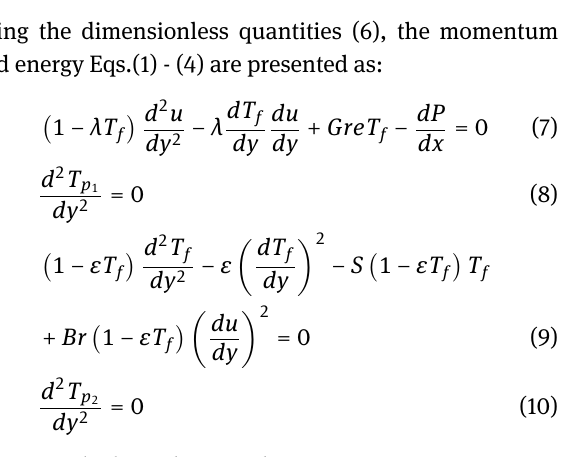
equations of the bounding slabs p 1 and p 2